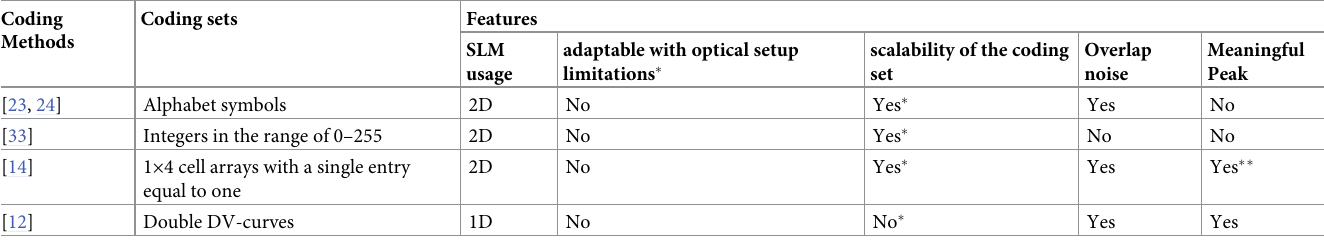
Table 2. Related methods’ features summary. Coding Coding Methods